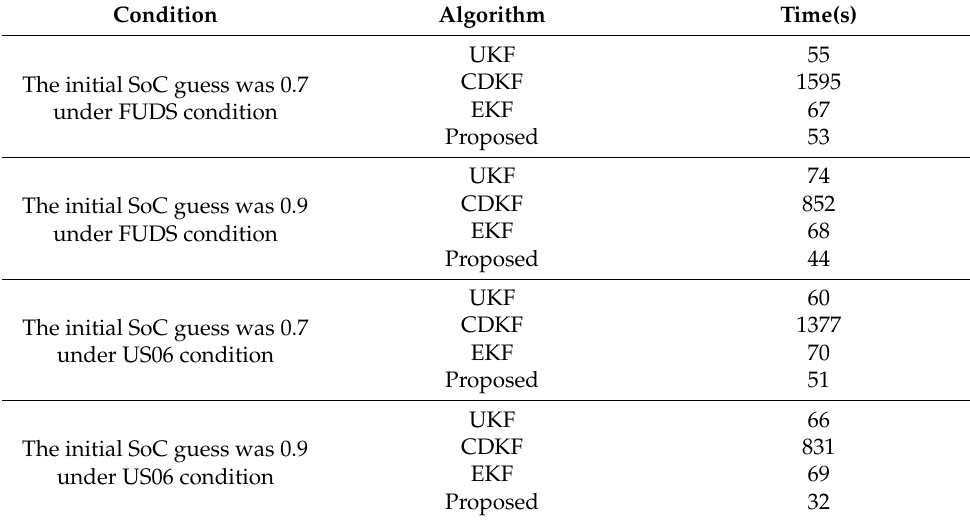
Table 7. The time of initial error